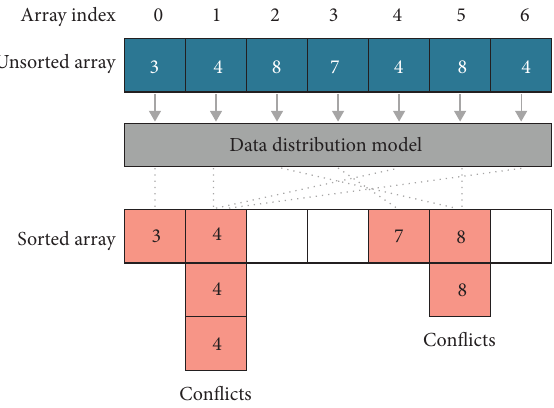
Figure 2: Illustration of placement